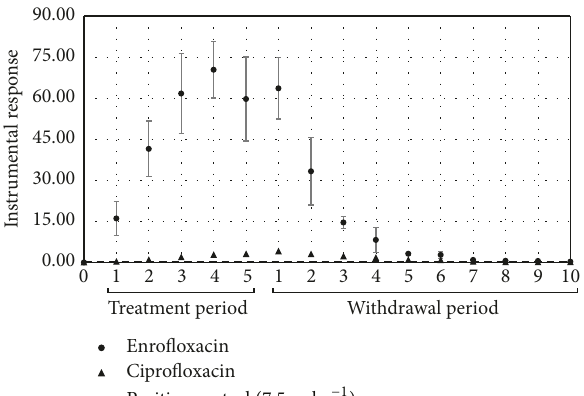
Figure 2: Residues of enrofloxacin and ciprofloxacin in egg samples from layer hens subjected to a pharmacological treatment with enrofloxacin, during the drugs administration period and days of residual evaluation.